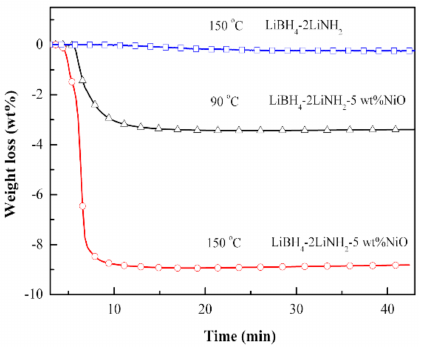
Figure 6. Isothermal dehydrogenation curves of the LiBH 4 -2LiNH 2 -NiO.